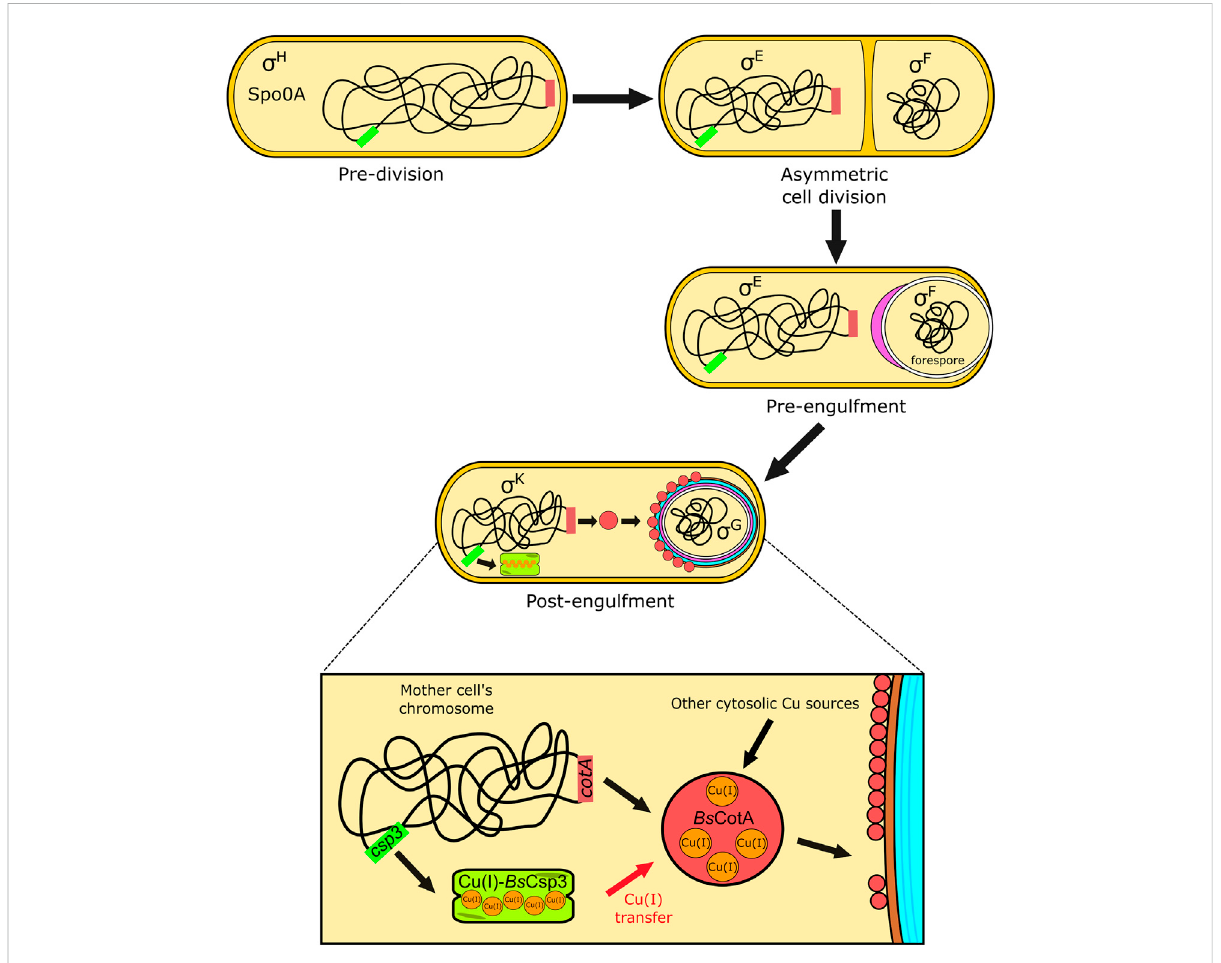
FIGURE 4 The proposed role of Bs Csp3 in Cu(I) acquisition by Bs CotA during sporulation in B. subtilis . The transcription factor Spo0A, along with σ H , initiates sporulation. A septum asymmetrically divides the cell into the forespore and mother cell, with σ E and σ F , respectively, activated within these. The mother cell begins engulfment of the forespore and σ E directs gene expression and initiation of spore coat (purple) formation. The expression of Bs Csp3 and Bs CotA now begins, promoted by σ K (see Figure 1F) and coat assembly continues. We propose that Bs Csp3 acquires Cu(I) during this stage of sporulation, which is transferred to Bs CotA prior to insertion of the Cu-enzyme into the spore